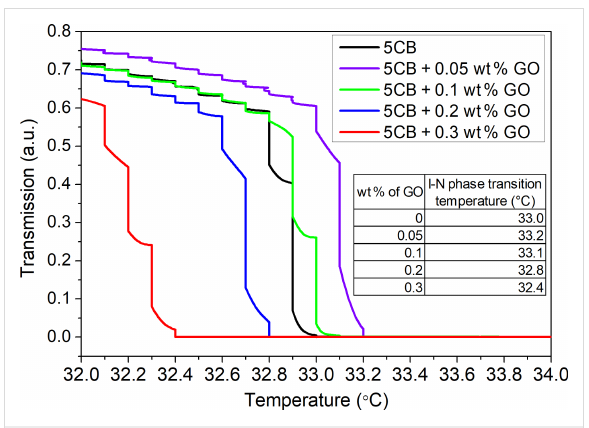
Figure 4: Normalized transmission upon temperature for the pure 5CB and the 5CB-GO composites. The inset shows the clearing tempera- ture dependence on the GO